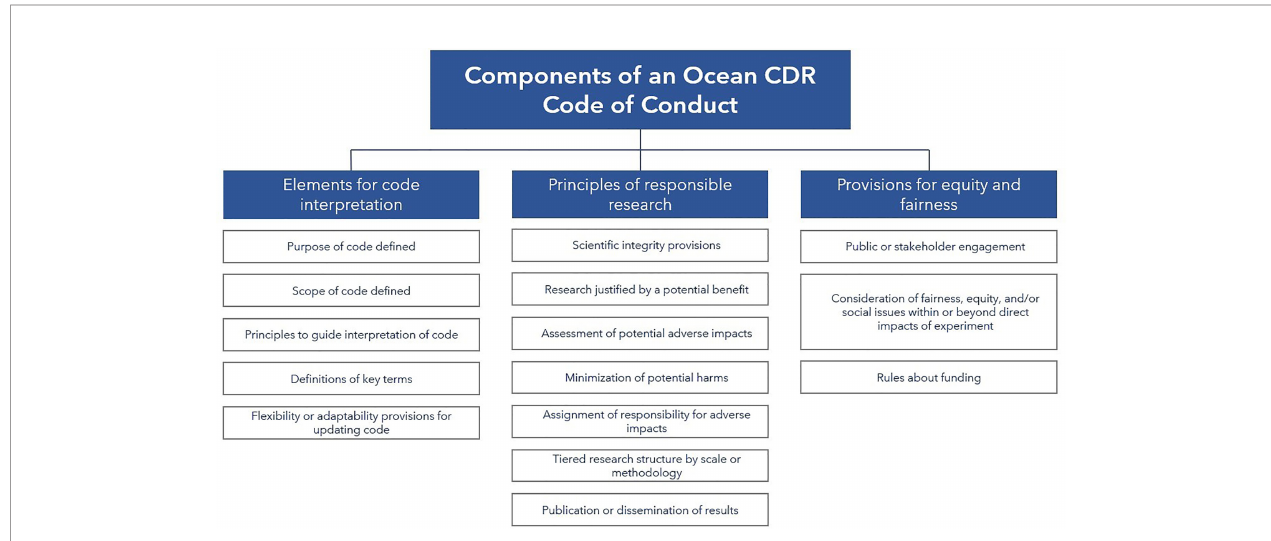
FIGURE 1 | Key components for inclusion in a research code of conduct for ocean